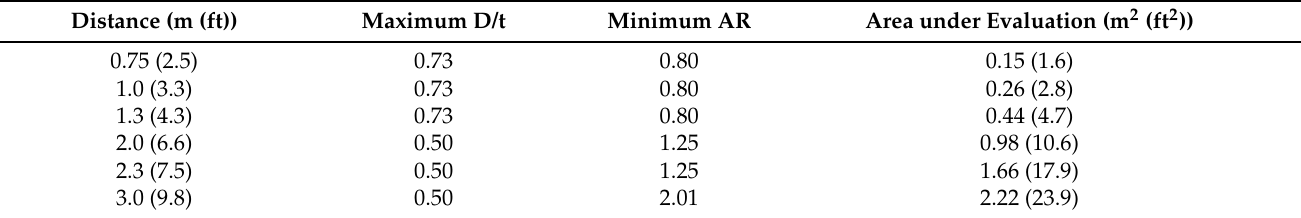
Table 7. Accuracy of defect detection at different distances.